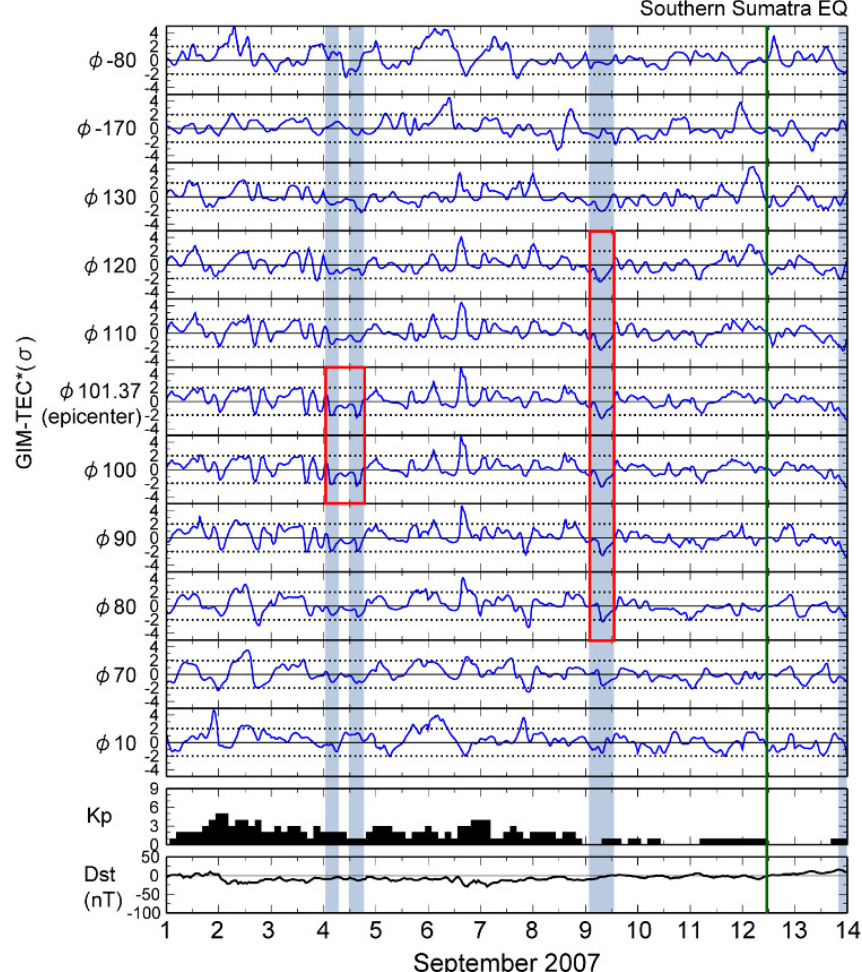
Fig. 5. Variations of GIM-TEC*, K p index, and Dst index from 1 September to 13 September 2007 for various longitudes. The solid green line shows the time at which the earthquake occurred. The blue areas indicate periods during which a significant decrease in GIM-TEC* over − 2 σ occurred at multiple stations. Red frames mark significant decreases in GIM-TEC* around the